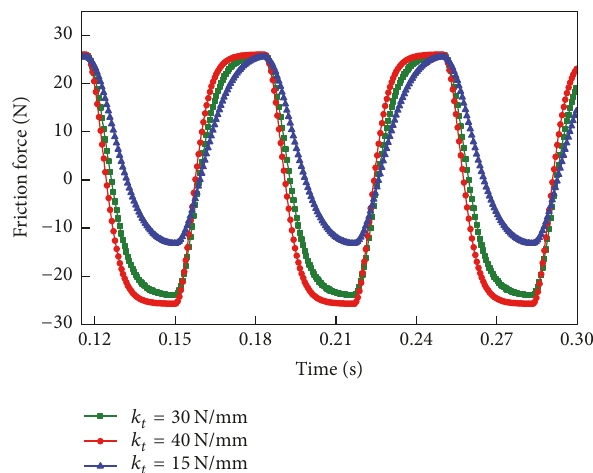
Figure 10: Influence of tangential contact stiffness coefficient on the change in friction.